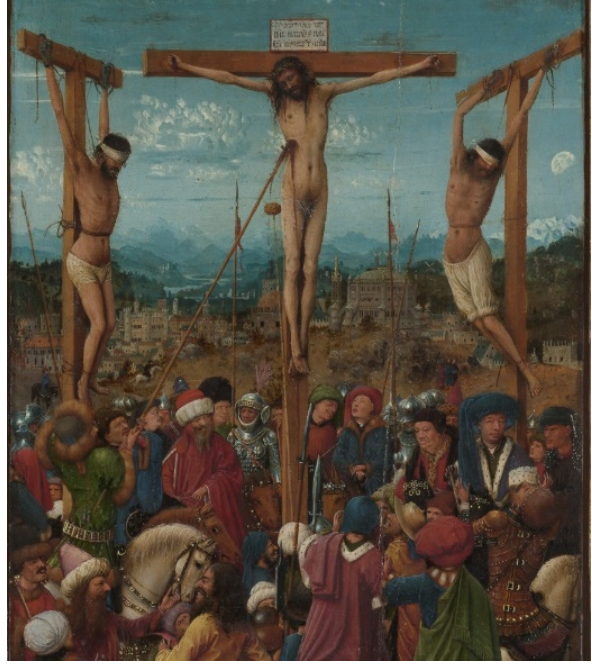
Figure 2. Detail of Figure 1.